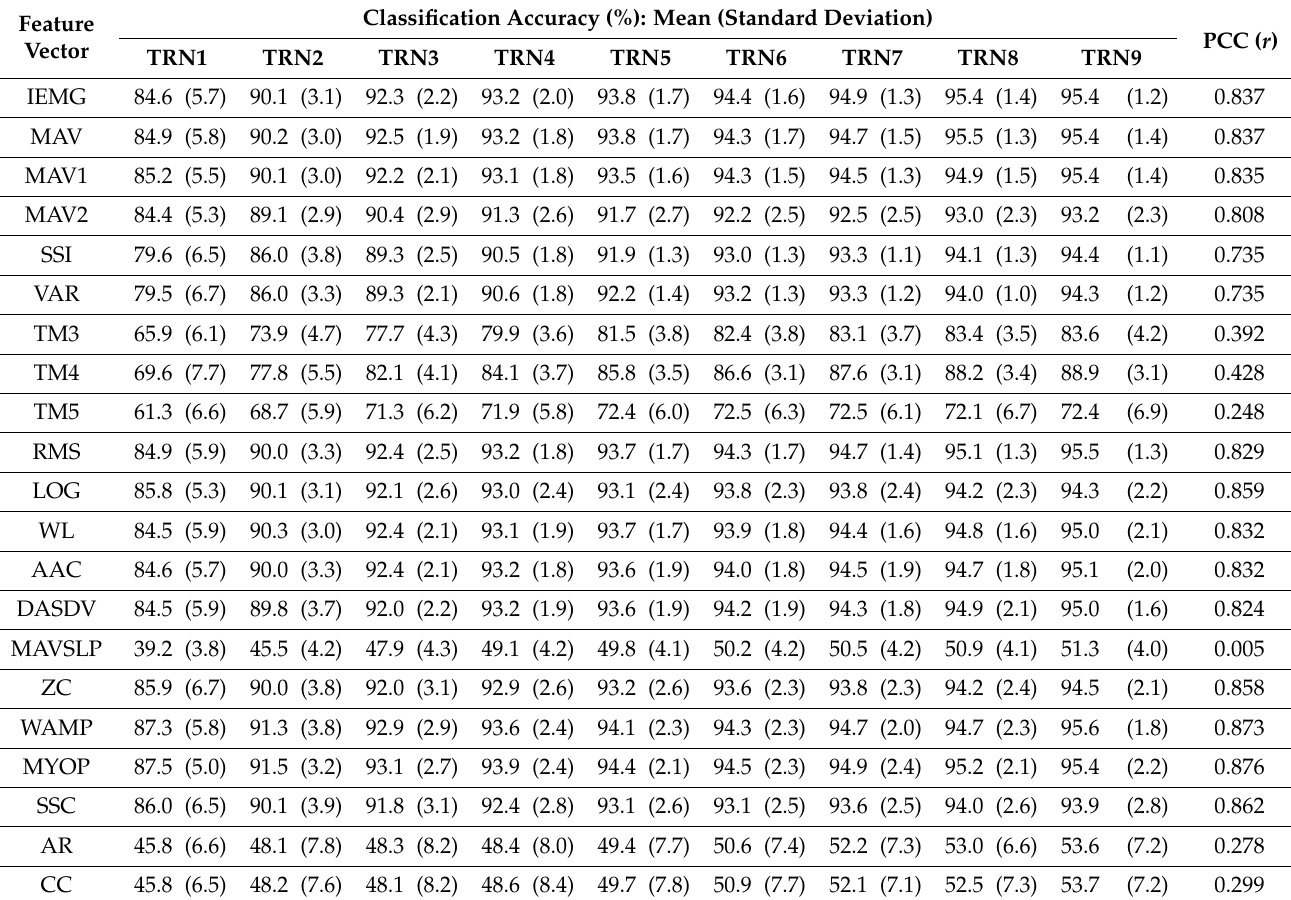
Table 3. Classification accuracy and inter-session PCC of the feature vectors in Group